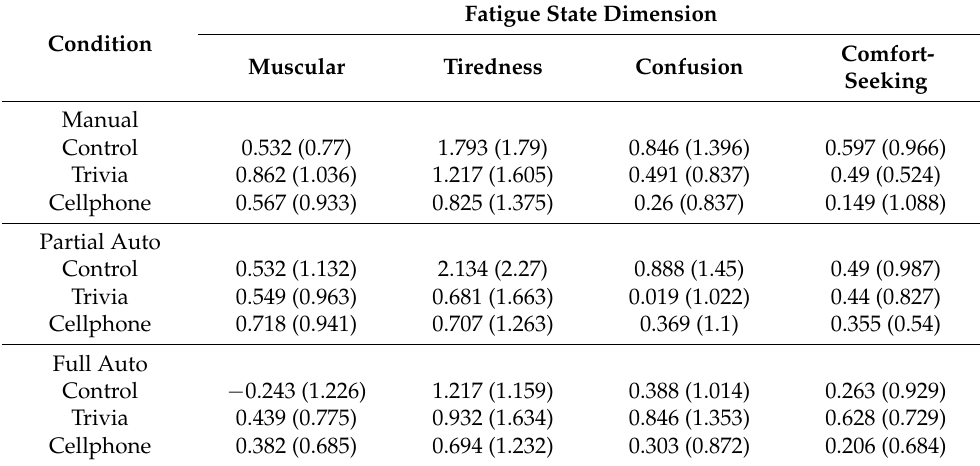
Table 2. Means (and SDs) of standardized fatigue state changes as a function of automation and secondary media